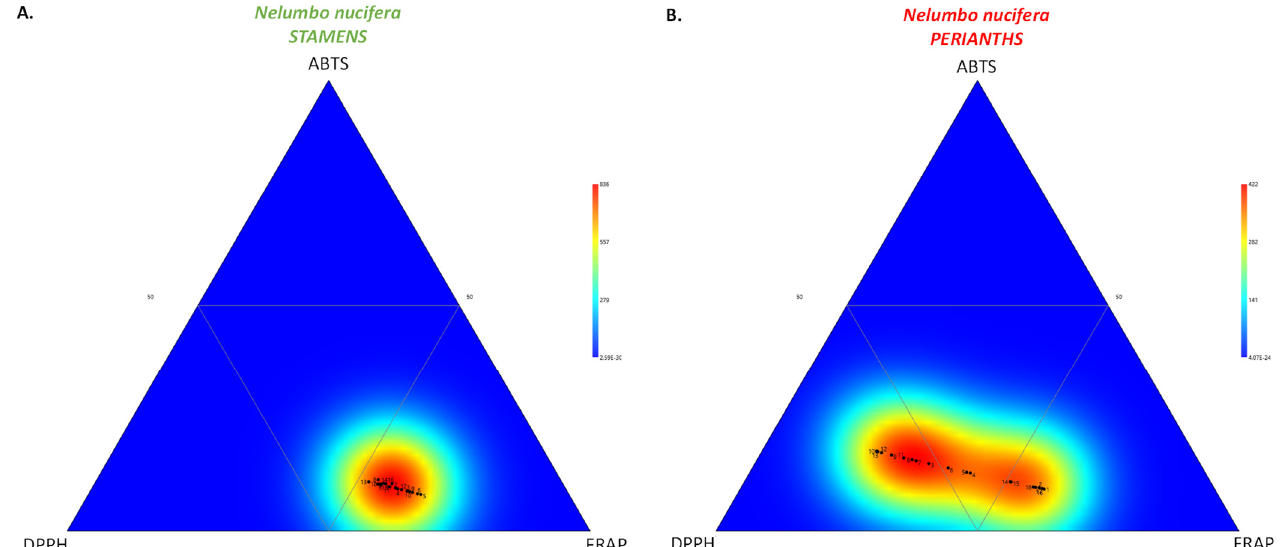
Figure 6. Ternary plot showing the visualization of the relative contribution of the different in vitro assays (ABTS, DPPH and FRAP) to the antioxidant capacitiy of the stamen ( A ) and perianth ( B ) extracts of 18 N. nucifera populations originating from various floristic regions from Thailand.